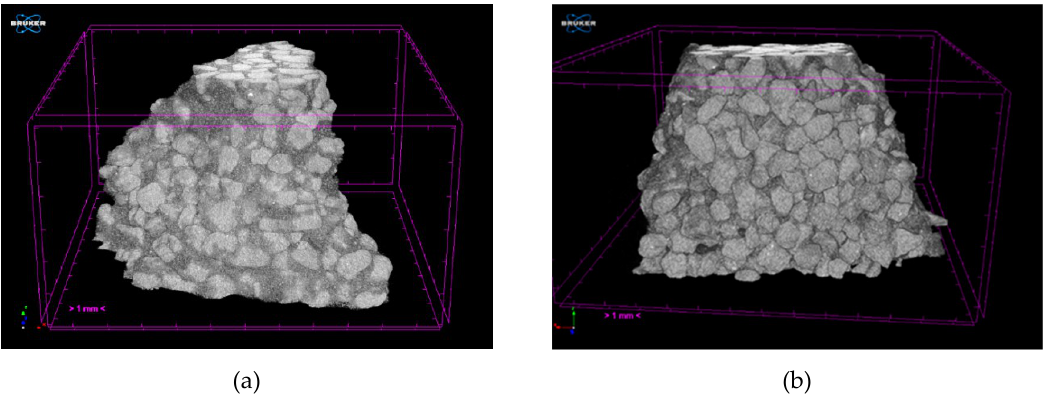
Figure 12. Three-dimensional reconstructions of: ( a ) Sample Q1 and ( b ) Sample Q2 post heating at 950 °C.